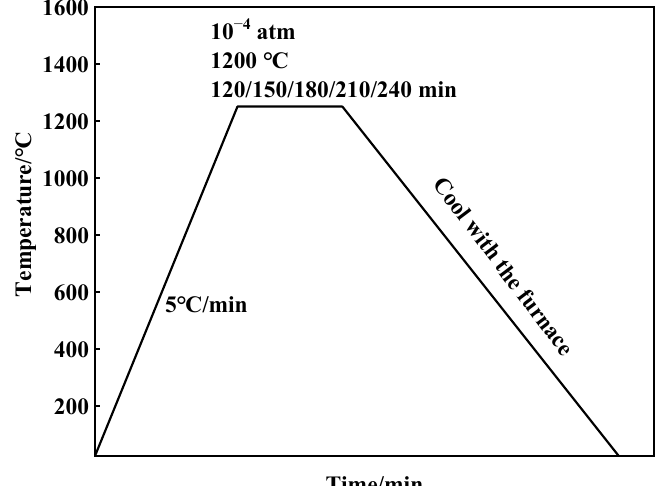
Figure 10. Vacuum reduction sintering system of porous 316 stainless steel.